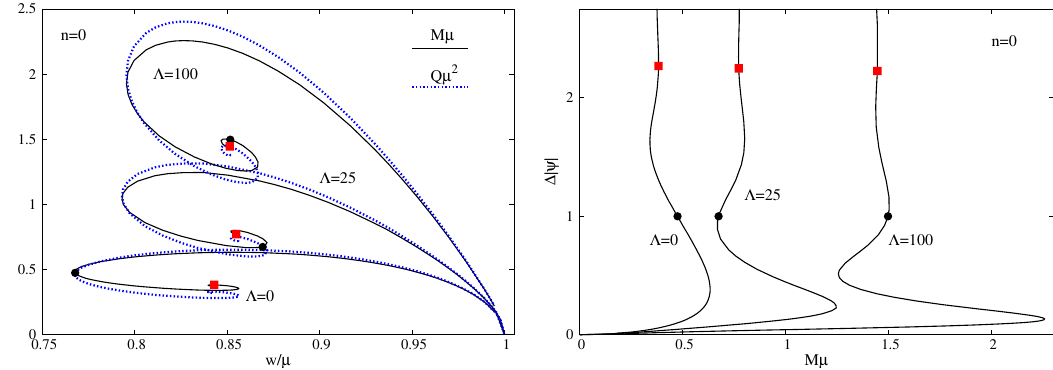
Figure 1 . (Left panel) ADM mass M or Noether charge Q vs. scalar (cid:12)eld frequency w diagram for static spherically symmetric boson stars with a quartic self-interaction and di(cid:11)erent values of the (rescaled) self-interaction coupling (cid:3), where (cid:3) = (cid:21)=(cid:22) 2 . (Right panel) Maximal variation of the scalar (cid:12)eld as a function of the ADM mass for the same con(cid:12)gurations. In both plots, the black dots indicate where the swampland criteria start to fail, while the red squares show where the boson stars become ultra-compact. Only fundamental states are shown (zero nodes, n =